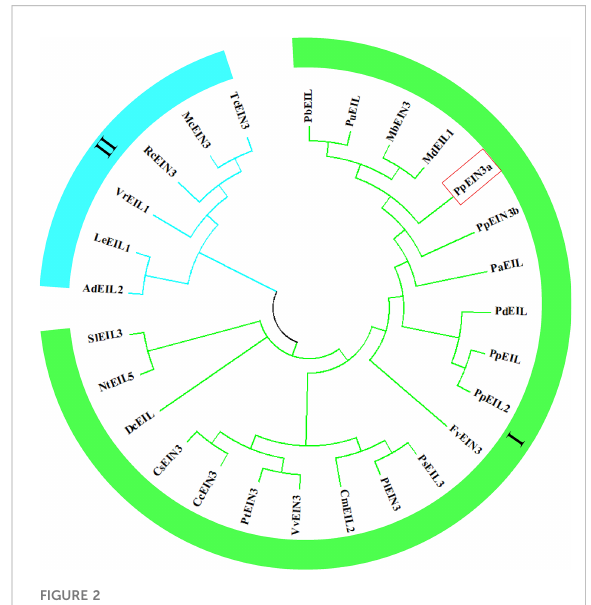
FIGURE 2 Evolutionary relationships of the PpEIN3a protein with respect to other EIN3/EIL proteins. The neighbor-joining evolution tree was constructed in MEGA 7. The accession numbers of the plant EIN3/EIL proteins in GenBank are: KT726838 ( Pyrus pyrifolia PpEIN3a), XP_009355060 ( Pyrus x bretschneideri PbEIL), KAB2627254 ( Pyrus ussuriensis x Pyrus communis PuEIL), TQD73050 ( Malus baccata MbEIN3), XP_008346133 ( Malus x domestica MdEIL1), KT726839 ( Pyrus pyrifolia PpEIN3b), XP_034202621 ( Prunus dulcis PdEIL), XP_020411970 ( Prunus persica PpEIL), XP_021834590 ( Prunus avium PaEIL), EF031066 ( Prunus persica PpEIL2), XM_006379360 ( Populus trichocarpa PtEIN3), NM_001247617 ( Solanum lycopersicum SlEIL3), XM_002530146 ( Ricinus communis RcEIN3),